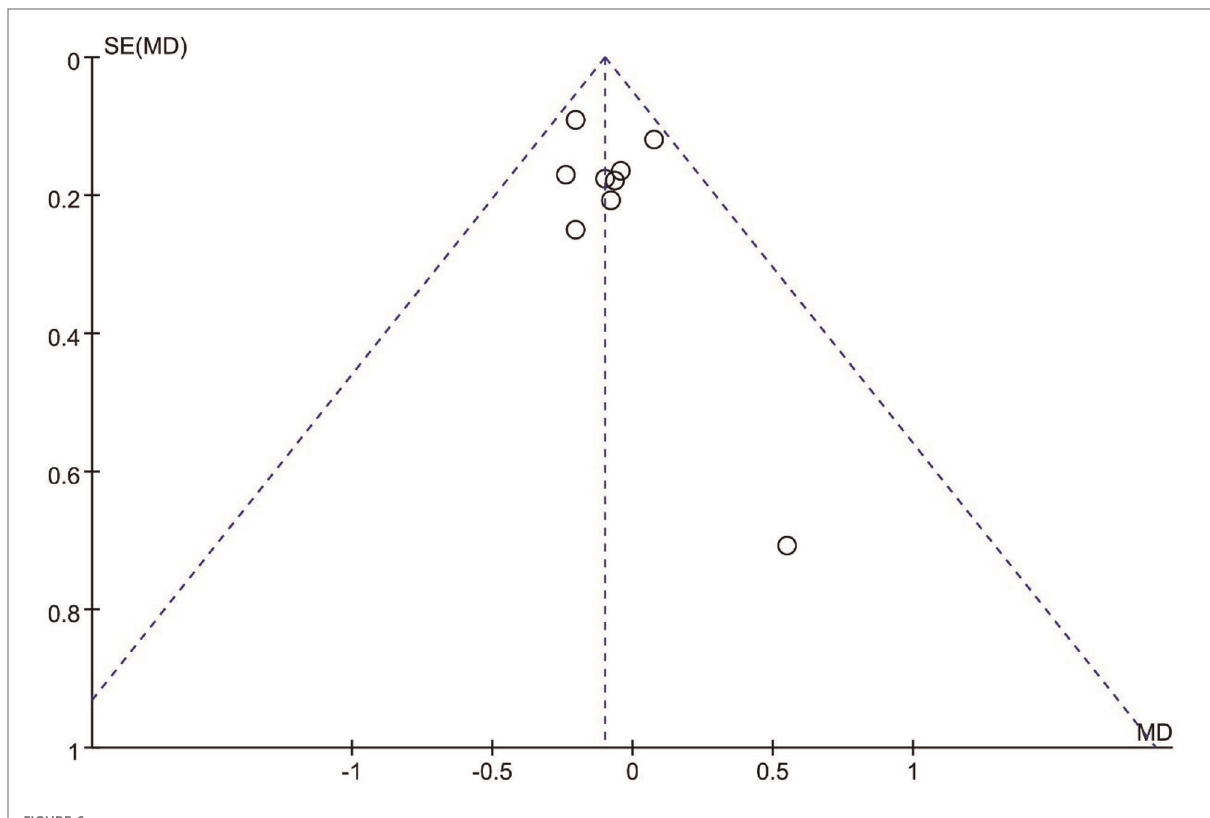
FIGURE 6 Publication bias of long term Vas back pain UBE vs MED.